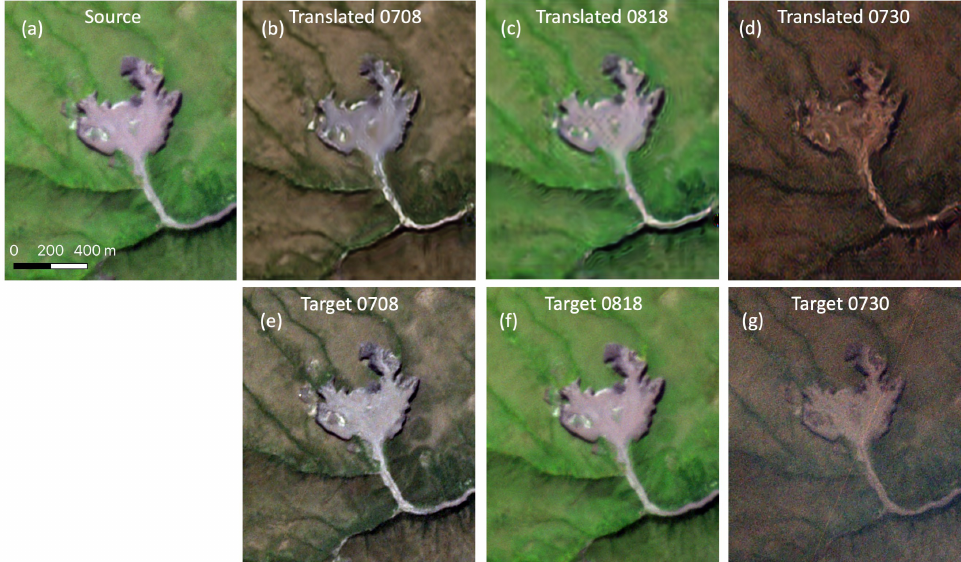
Figure 8. Source and translated images from the WR region: ( a ) is a sub-image from a source domain (the mosaic image), and ( b – d ) are translated images by different well-trained CycleGAN models. ( e – g ) are the corresponding target images. The numbers at the top or each image (e.g., 0708) show the acquisition dates of images in target